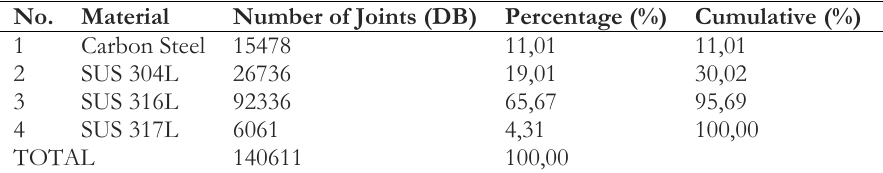
Table 1. Types of piping materials in the pipeline construction work process in 2019.